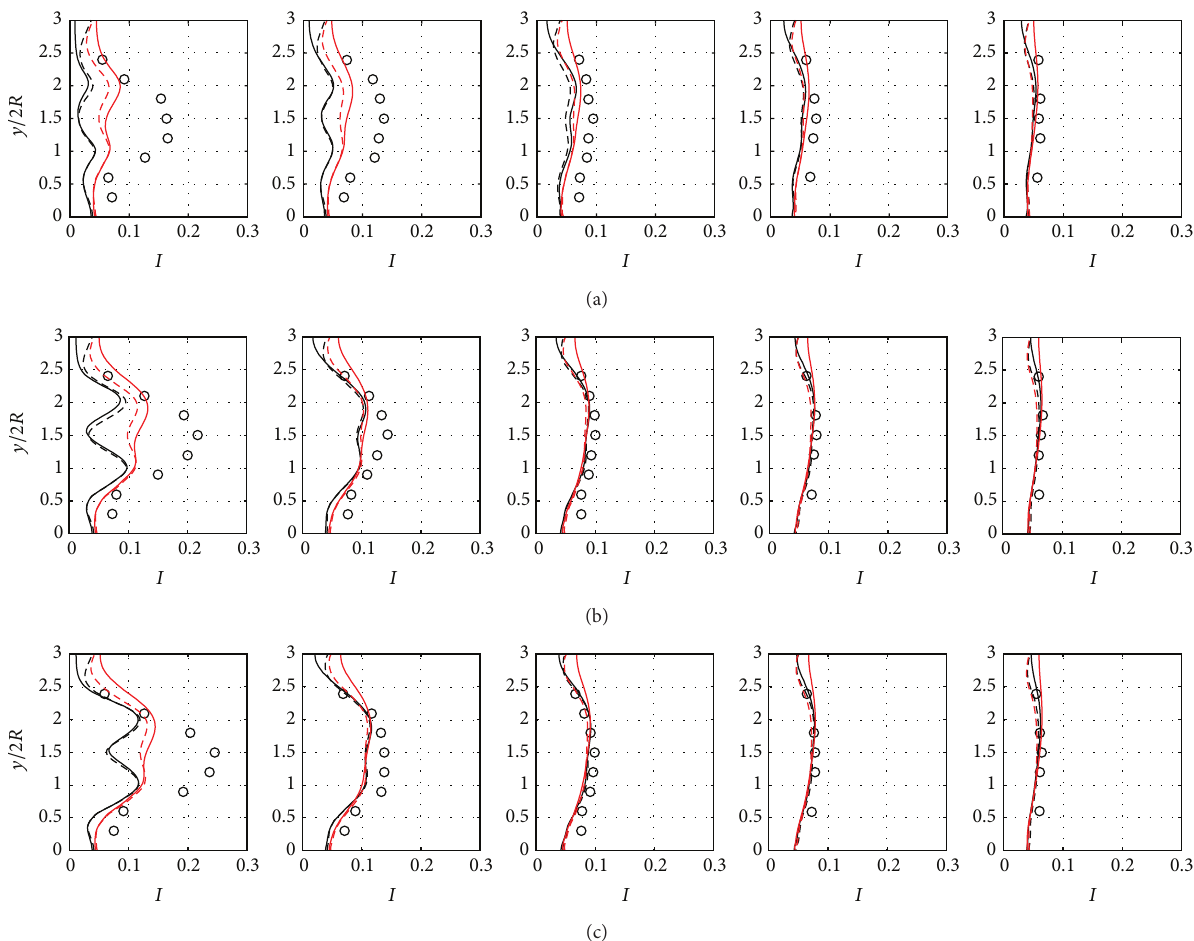
Figure 8: Turbulence intensity at 8𝑅 , 14𝑅 , 22𝑅 , 30𝑅 , and 40𝑅 downstream of the disc, with the channel (solid line), duct (dashed line), and experimental data ( ⃝ ) [11] at different 𝐶 𝑇 values of (a) 0.61, 0.62, (b) 0.86, 0.91, and (c) 0.97, 0.99 for this study and the experiment study, respectively [11]. The inlet 1 simulations are shown in black and inlet 2 simulations are in